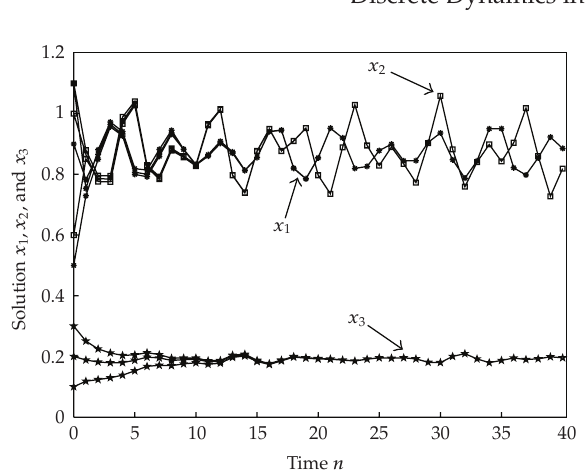
Figure 1: Dynamics behaviors of system (cid:3) 4.1 (cid:5) with initial conditions (cid:3) x 1 (cid:3) s (cid:5) ,x 2 (cid:3) s (cid:5) ,x 3 (cid:3) s (cid:5)(cid:5) T (cid:6) (cid:3) 0 . 5 , 1 , 0 . 3 (cid:5) T , (cid:3) 1 . 1 , 1 . 1 , 0 . 1 (cid:5) T , (cid:3) 0 . 9 , 0 . 6 , 0 . 2 (cid:5) T , s (cid:6) ..., − n, − n (cid:4) 1 ,..., − 1 , 0 .